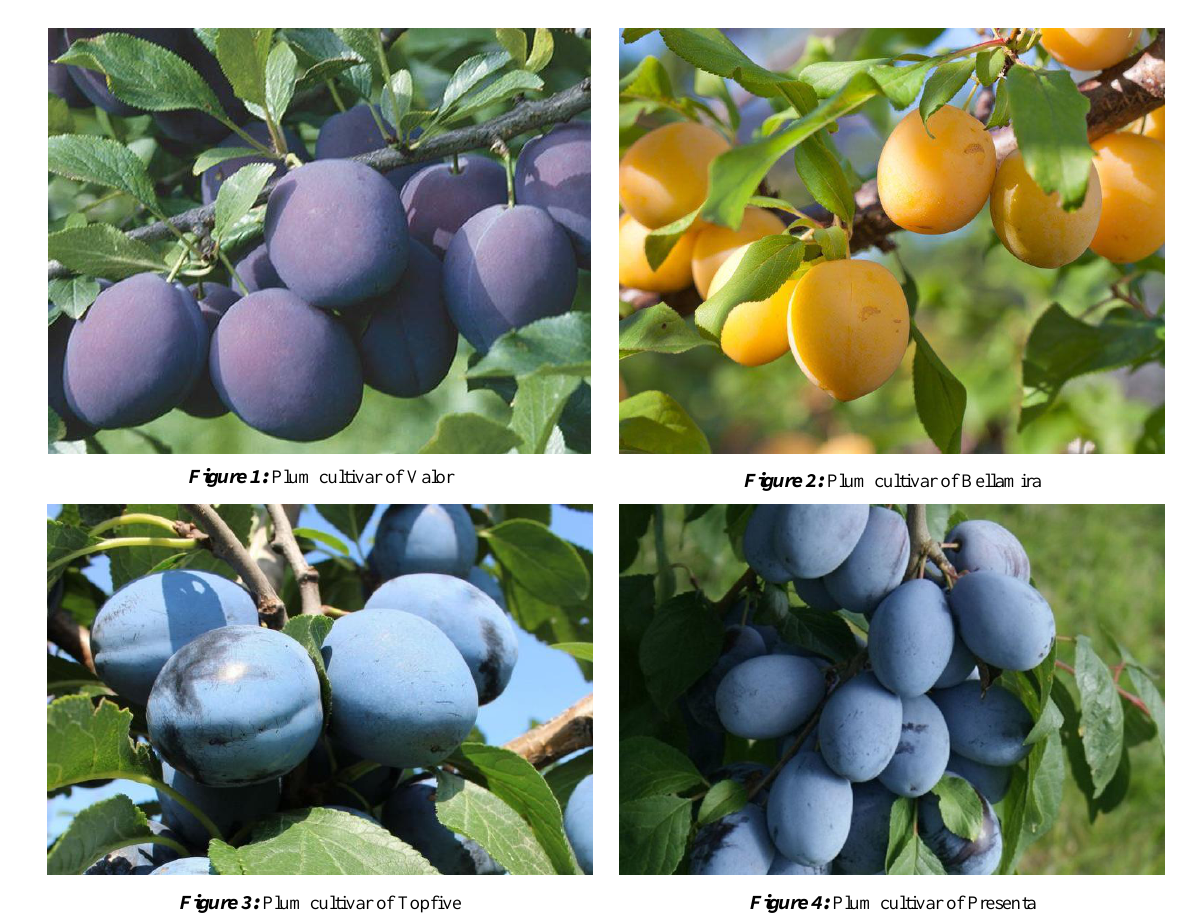
Figure 3: Plum cultivar of Topfive Figure 4: Plum cultivar of